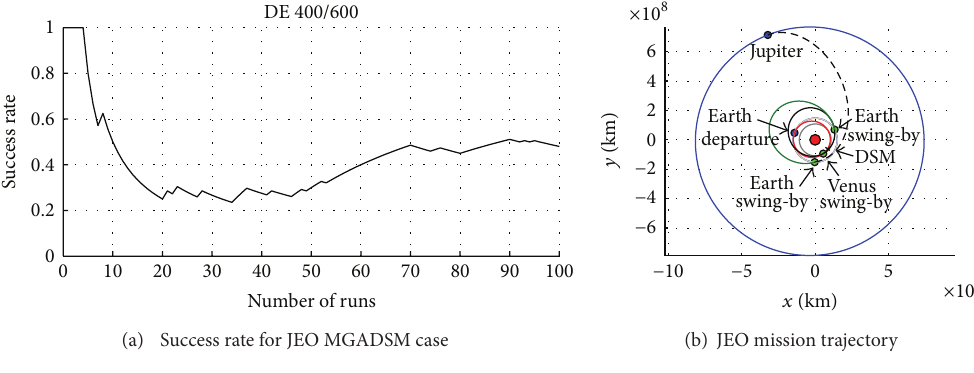
Figure 6: The success rate and the trajectory for the JEO MGADSM case.